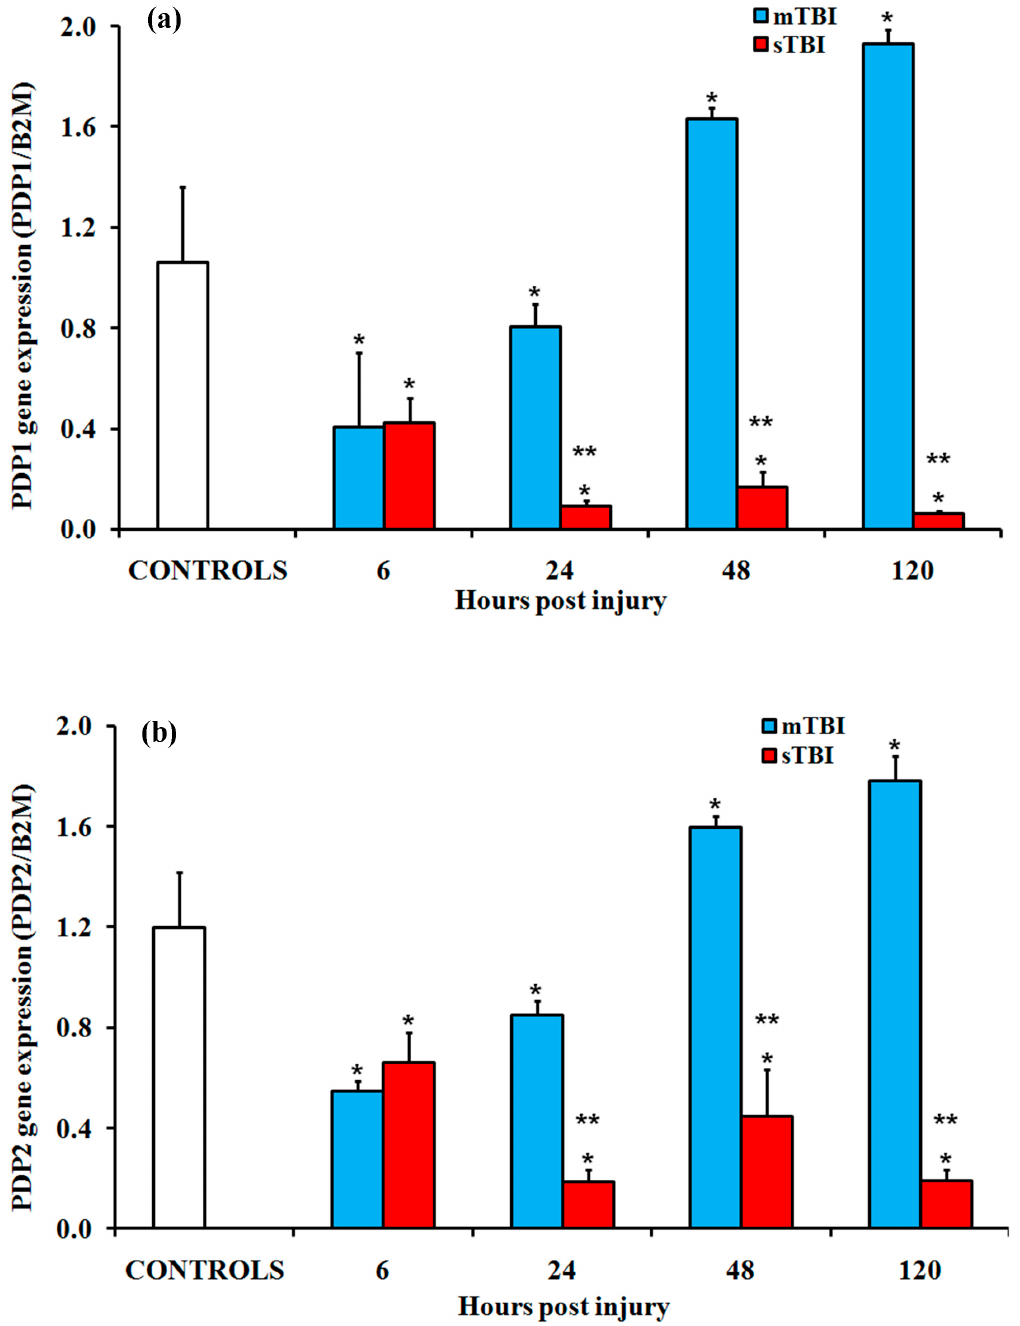
Figure 2. Changes in the expression of genes encoding for the two isoenzymes of pyruvate dehydrogenase phosphatase (PDP) in the brain tissue homogenates of rats receiving a TBI of di ff erent severities (mTBI or sTBI) at various times post-injury. ( a ) PDP1, the gene encoding for the isoform 1 of PDP and ( b ) PDP2, the gene encoding for isoform 2 of PDP. Values are the mean of six animals. Standard deviations are represented by vertical bars. Gene expressions were calculated relative to the expression of the housekeeping gene, β -2-microtubulin (B2M). * significantly di ff erent from the controls, p < 0.05. ** significantly di ff erent from the corresponding time of mTBI rats p < 0.05.